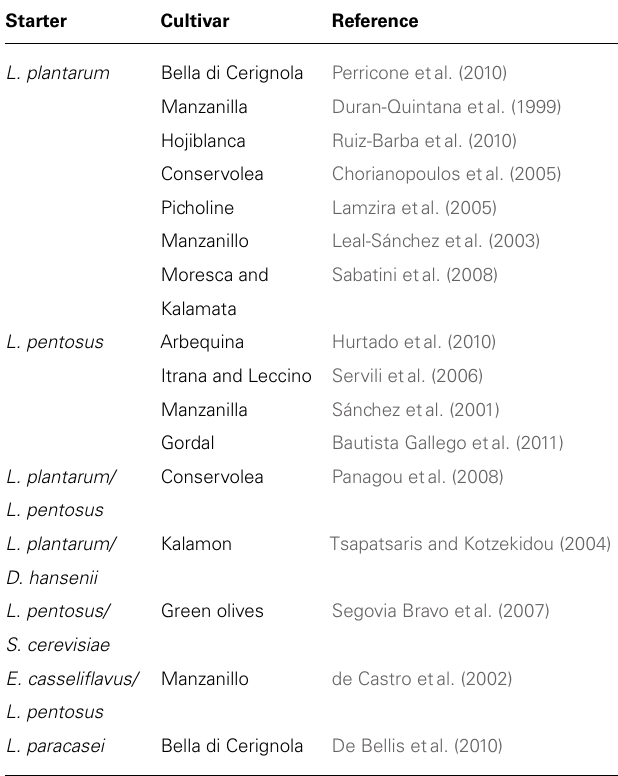
Table 1 | Main starter cultures used for table olive fermentation in experimental